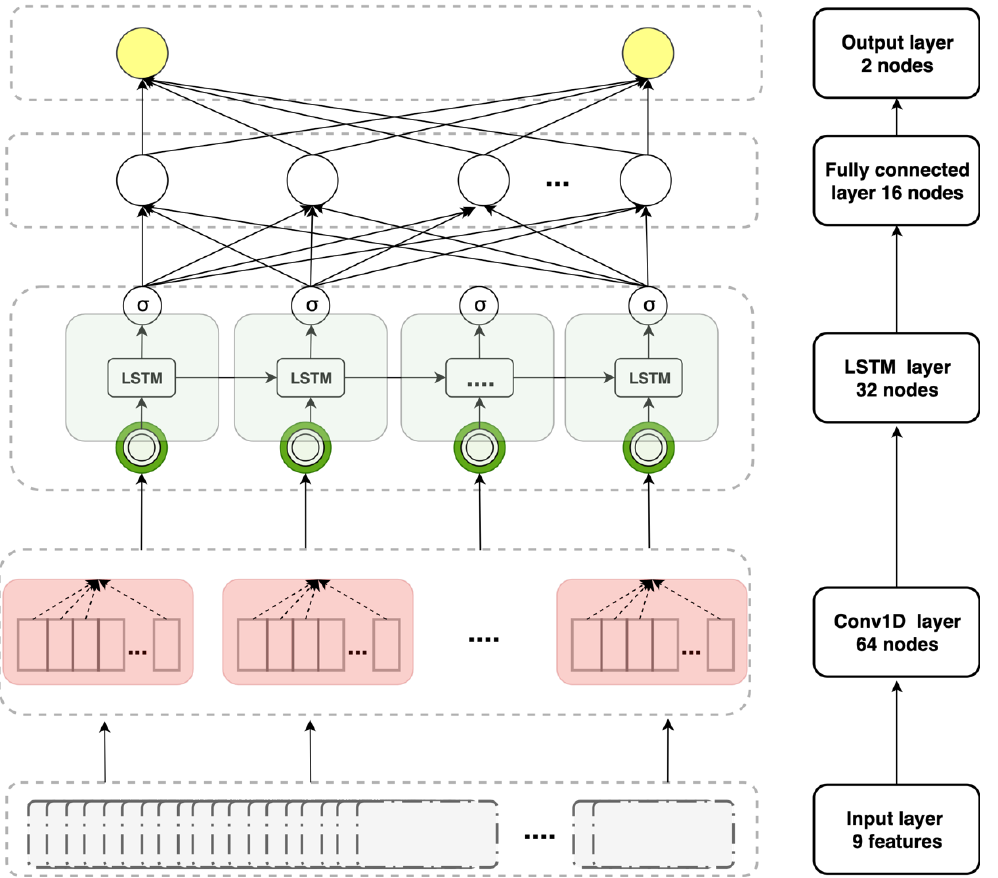
Figure 6. The layer structure of the convolutional neural network–long short-term (CNN–LSTM) model.